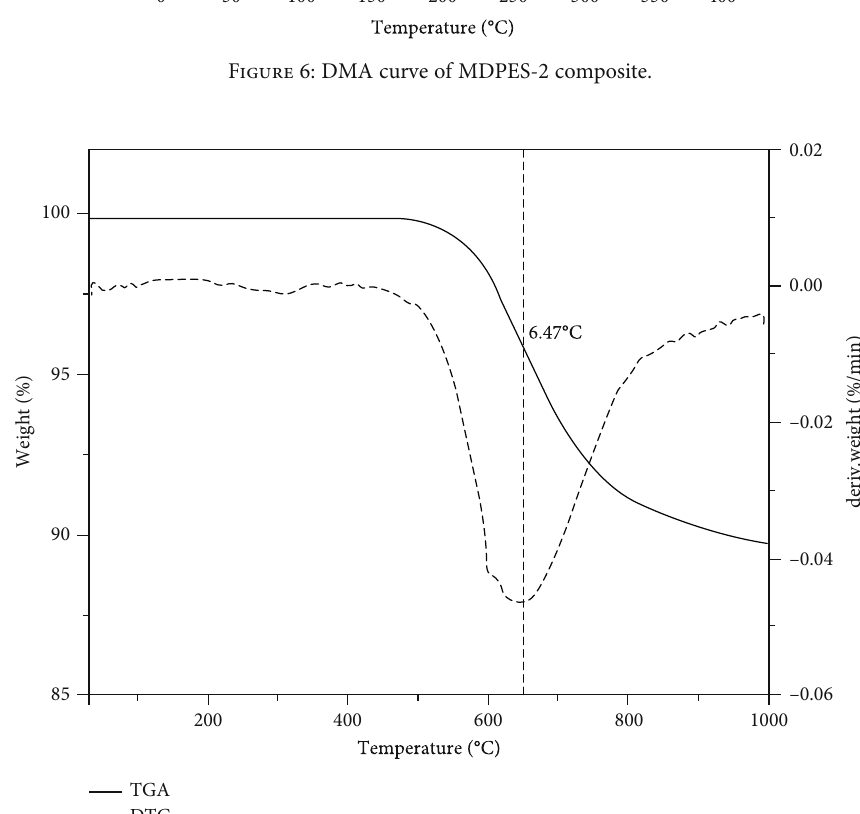
Figure 7: TGA curve of MDPES-2 resin in a fl ow of